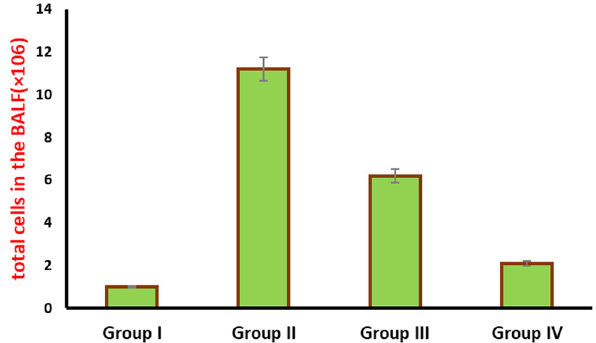
Figure 6: E ff ect of AuNPs on total number of cells in